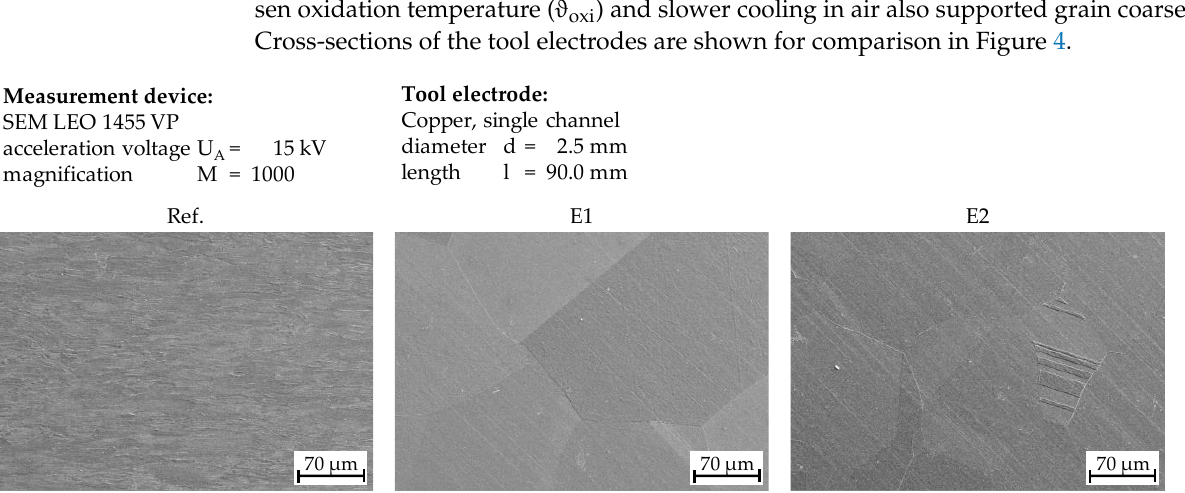
ening. Cross-sections of the tool electrodes are shown for comparison in Figure 4.